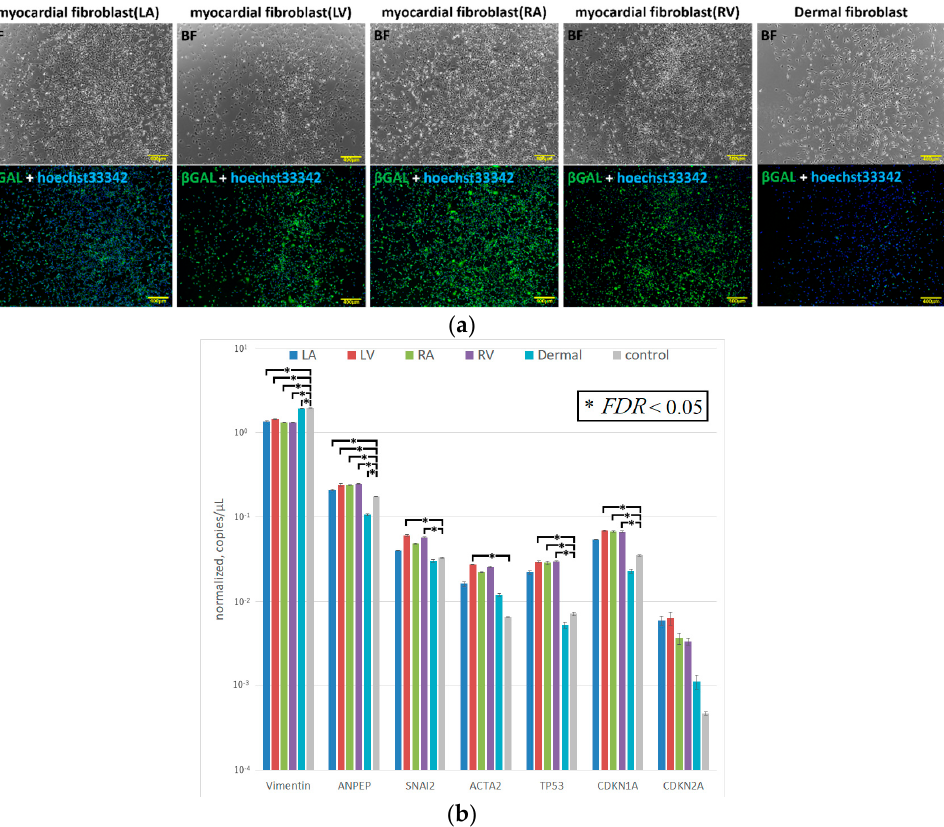
Figure 5. Heart transplant recipient tissue characteristics. ( a ) Bright field (BF; top) and double-stained (subjected to immunofluorescent staining of SA- β -Gal ( β GAL) and hoechst33342 staining) images of primary cultured dermal fibroblasts and myocardial fibroblasts derived from a heart transplant recipient. From left to right, myocardial fibroblasts from the left atrium (LA), left ventricle (LV), right atrium (RA), and right ventricle (RV) and dermal fibroblasts are shown. Scale bars: 400 µm. ( b ) Expression levels of vimentin, ANPEP, SNAI2, ACTA2, TP53, CDKN1A, and CDKN2A in myocardial and dermal fibroblasts from a heart transplant recipient. Values shown are the mean ± SEM (* FDR < 0.05, by two-way ANOVA).